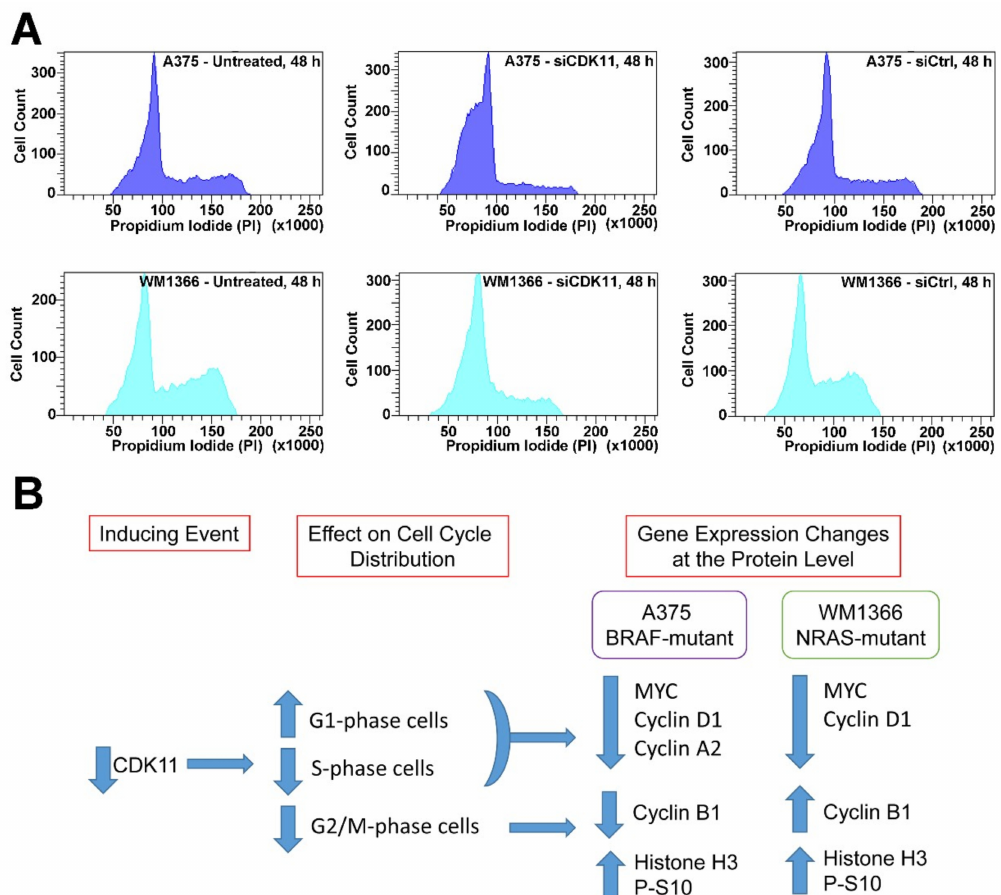
Figure 6. FACS analysis for cell cycle composition following siRNA-mediated down-regulation of CDK11 in melanoma cells and summary of cell cycle-related results. ( A ) PI-based FACS analysis for DNA content in untreated and siCDK11 and siControl transfected A375 (upper panels) and WM1366 (lower panels) cells is shown. The identity of the treatment type and time point is indicated within each panel. ( B ) A cartoon summary of the cell cycle-based alterations in melanoma cells after CDK11 downregulation and the associated changes in protein expression